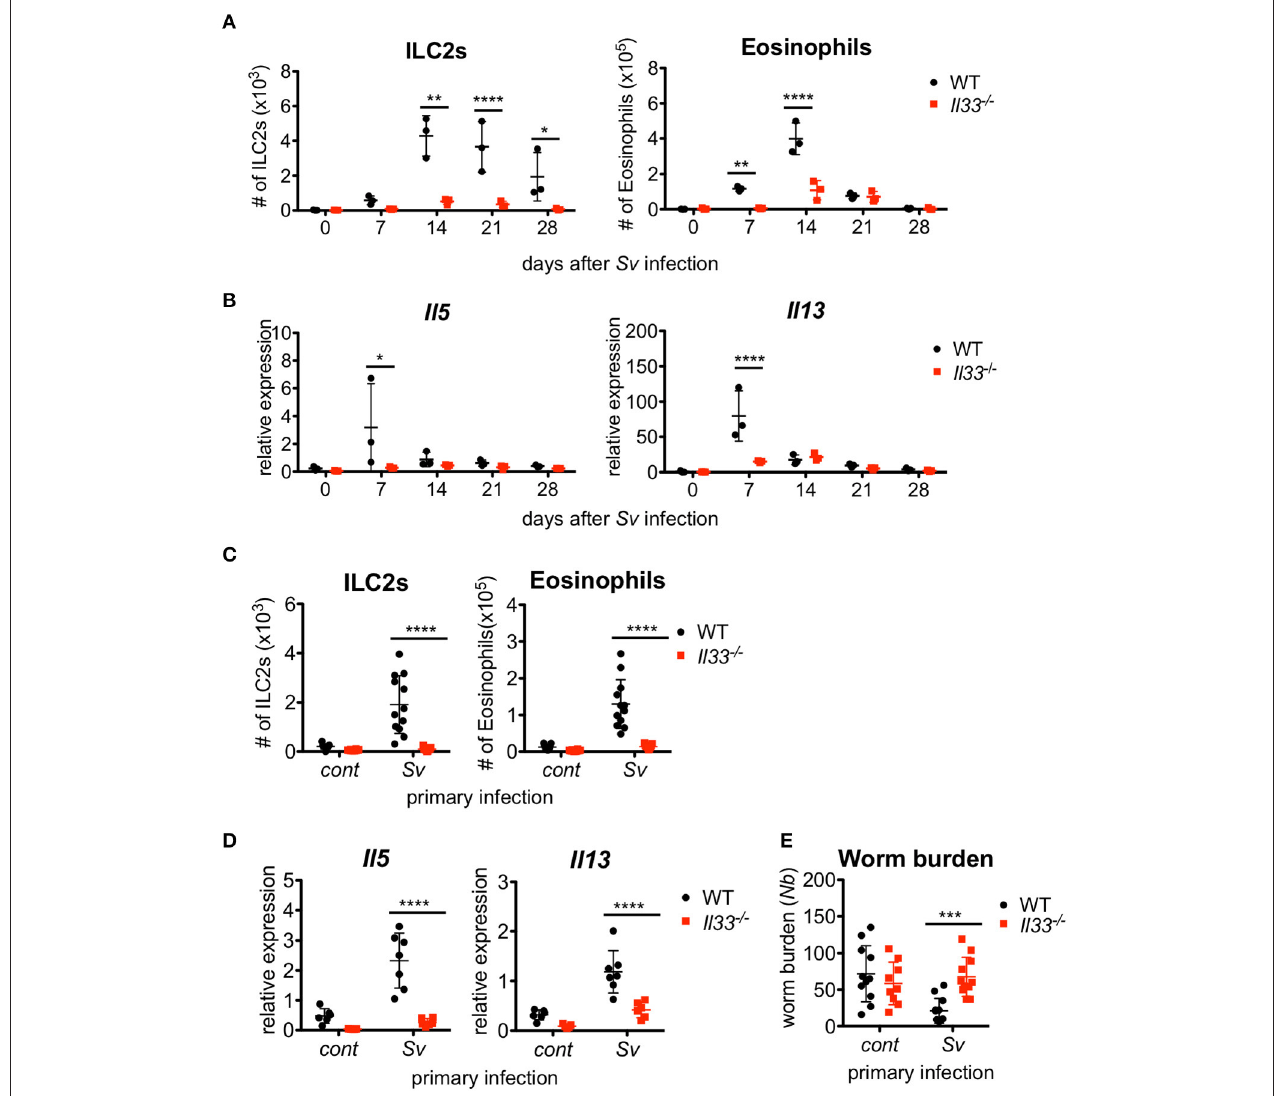
FIGURE 4 | IL-33 is critical for the enhanced inflammation and the protection against Nippostrongylus brasiliensis infection. WT and Il33 − / − mice ( n = 3) were infected with S. venezuelensis (Sv) at day 0. (A) BALF cells from uninfected (day 0) or S. venezuelensis -infected mice at the indicated days were analyzed as in Figure 1H . Data are representative of two independent experiments that had similar results. (B) Il5 and Il13 mRNA expression levels in the lungs were examined. (C–E) WT and Il33 − / − mice were infected with N. brasiliensis 4 weeks after S. venezuelensis (Sv) infection. S. venezuelensis -uninfected mice were used as a control (cont). Five days after N. brasiliensis infection, the number of ILC2s and eosinophils ( n = 10–12) (C) and the Il5 and Il13 mRNA expression levels ( n = 5–7) in the lungs were examined (D) . (E) The numbers of worms in the intestine were counted ( n = 10–12). Pooled data from (C,E) or representative of (D) two independent experiments are shown (Mean ±